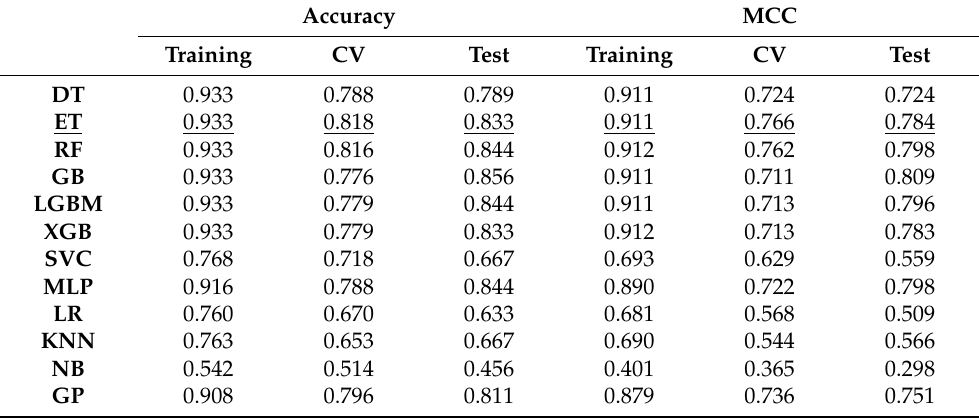
Table 3. Performance metrics of model I built with the 12 classification algorithms. The abbreviations of the algorithms are defined in the text. The performance is evaluated via the accuracy and MCC. Additionally, the performance is calculated separately for the training set (labeled as Training), the 10-fold cross-validation (labeled as CV), and the test set (labeled as Test). PubChem fingerprint is employed to represent the structures. The best performing algorithm is ET (underlined). Accuracy MCC CV